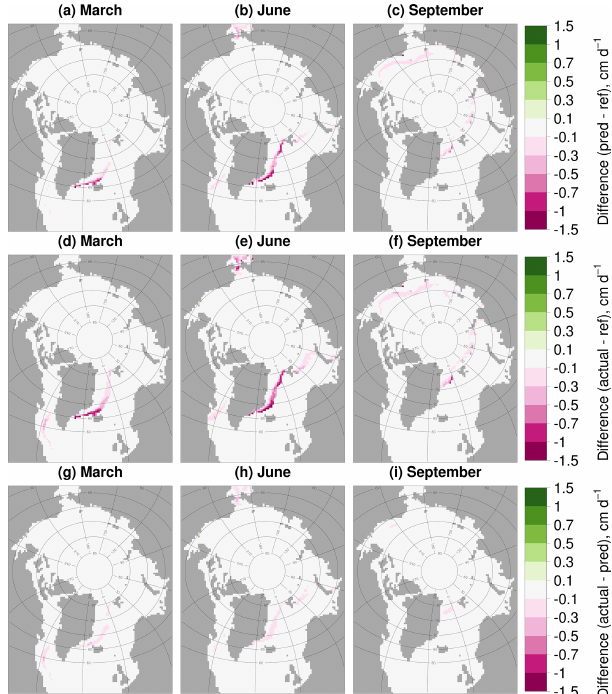
Figure 5. Predicted reduction in basal melt rate from stan-fsd to ref (a–c) , actual reduction in basal melt rate from stan-fsd to ref (d–f) , and difference between the actual reduction and predicted reduction in basal melt rate (g–i) averaged over 2007–2016. Re- sults are presented for March (a, d, g) , June (b, e, h) , and Septem- ber (c, f, i) . Values are shown only in locations where the sea ice concentration exceeds 5%. The predicted reduction in basal melt rate refers to the expected reduction if the change in sea ice area fraction is the only factor driving the change in basal melt rate. This is calculated by multiplying the basal melt rate for ref by the relative percent change in ice area fraction from ref to stan-fsd for each grid